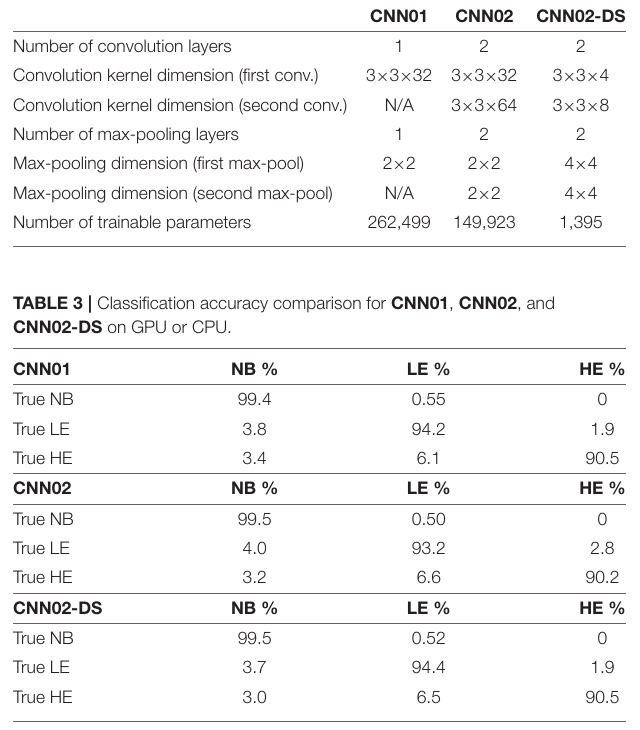
TABLE 2 | Summary of explored CNN architectures.